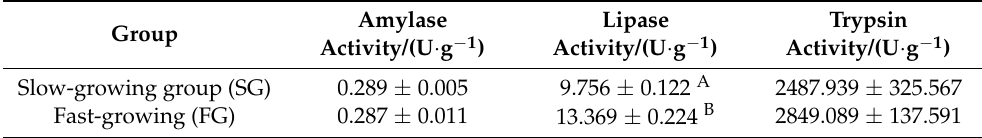
Table 2. Digestive enzyme activities of largemouth bass with different growth rates.